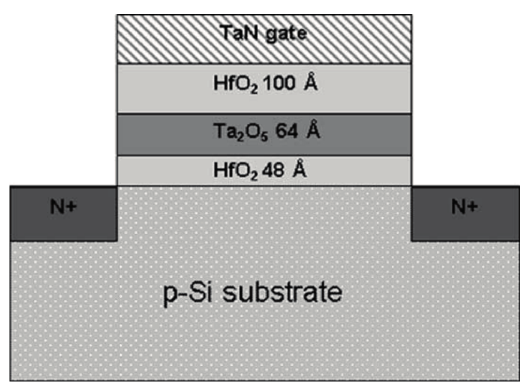
Figure 9. Fabricated metal-HfO permission from [45], Copyright 2004,